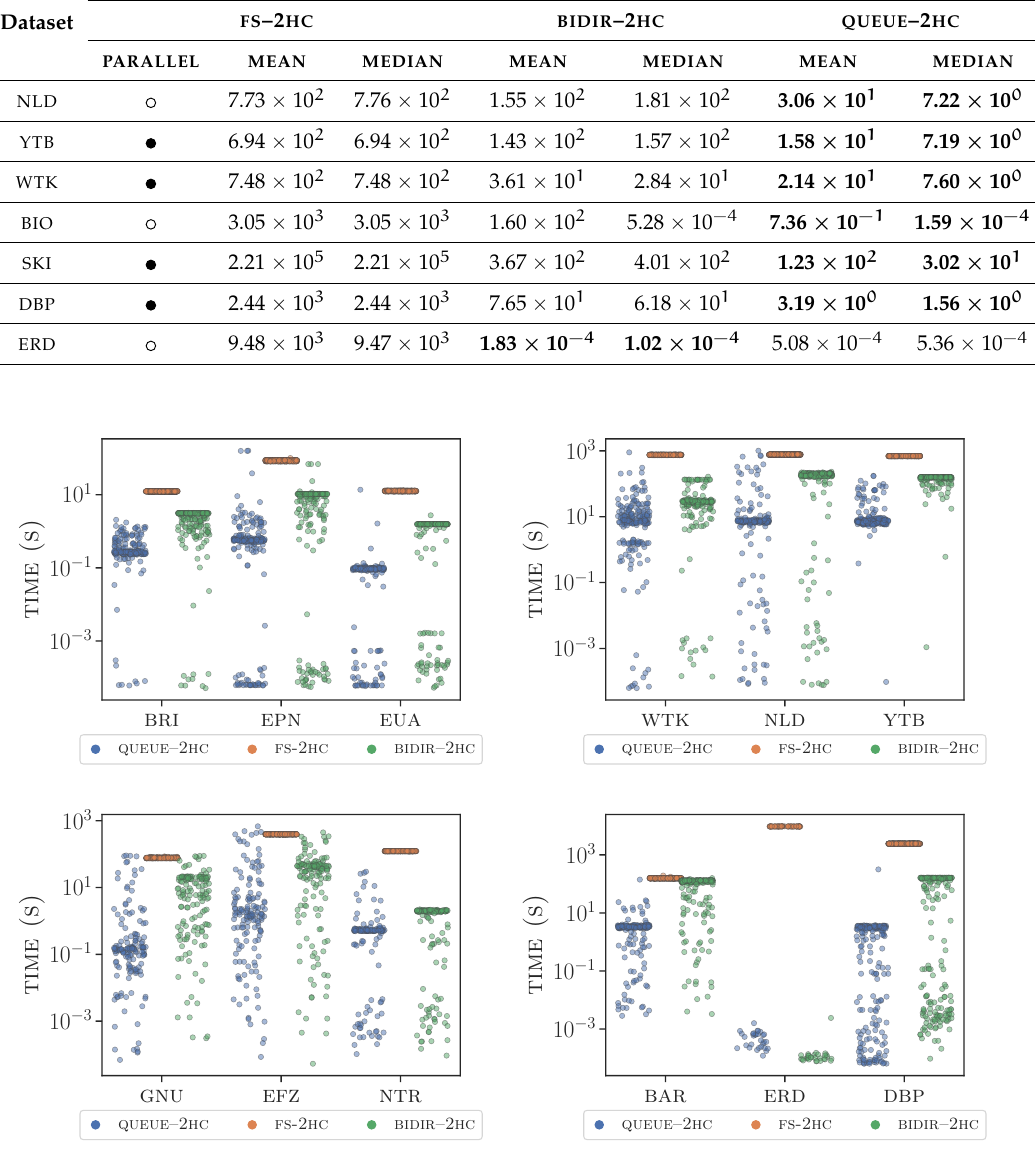
Figure 7. Running times of FS –2 HC , BIDIR –2 HC and QUEUE –2 HC on some of the considered inputs. The y -axis is log-scaled to magnify the